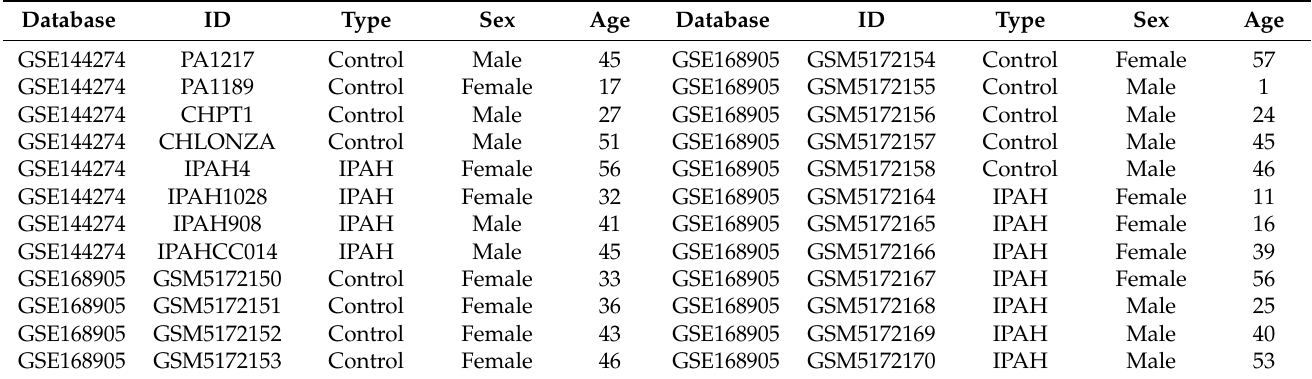
Table 2. The detailed information of IPAH and control samples in our